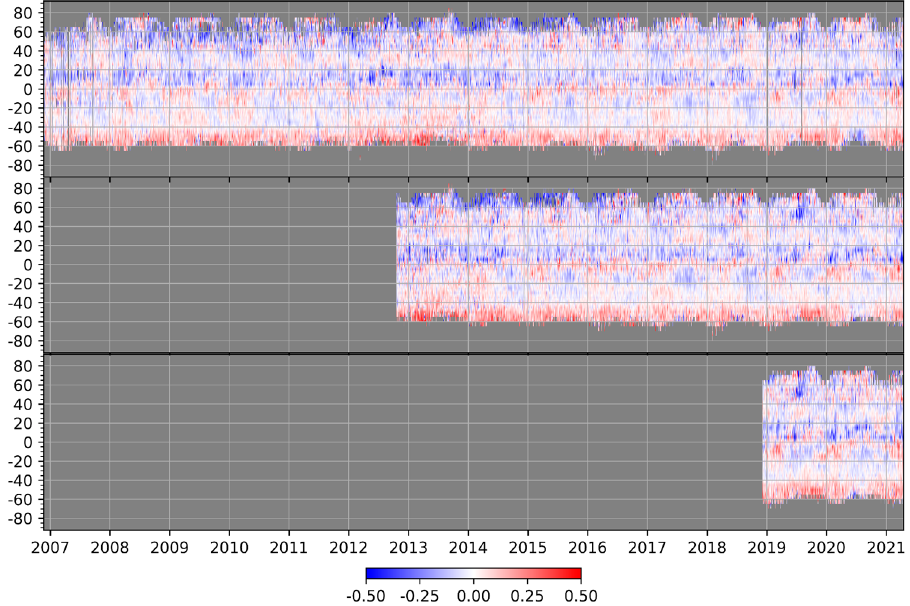
Figure 21. Same as in Figure 19 but for daytime GR—(D + TM) SST.